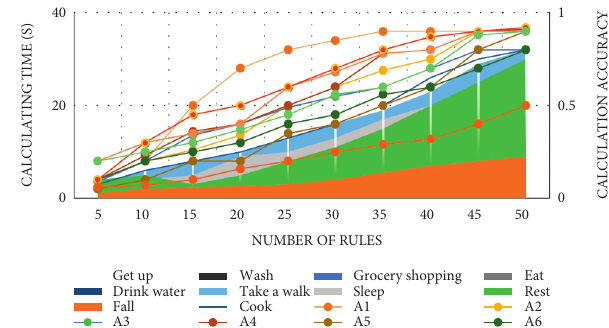
Figure 5: Sequence matching algorithm performance without rule pruning.